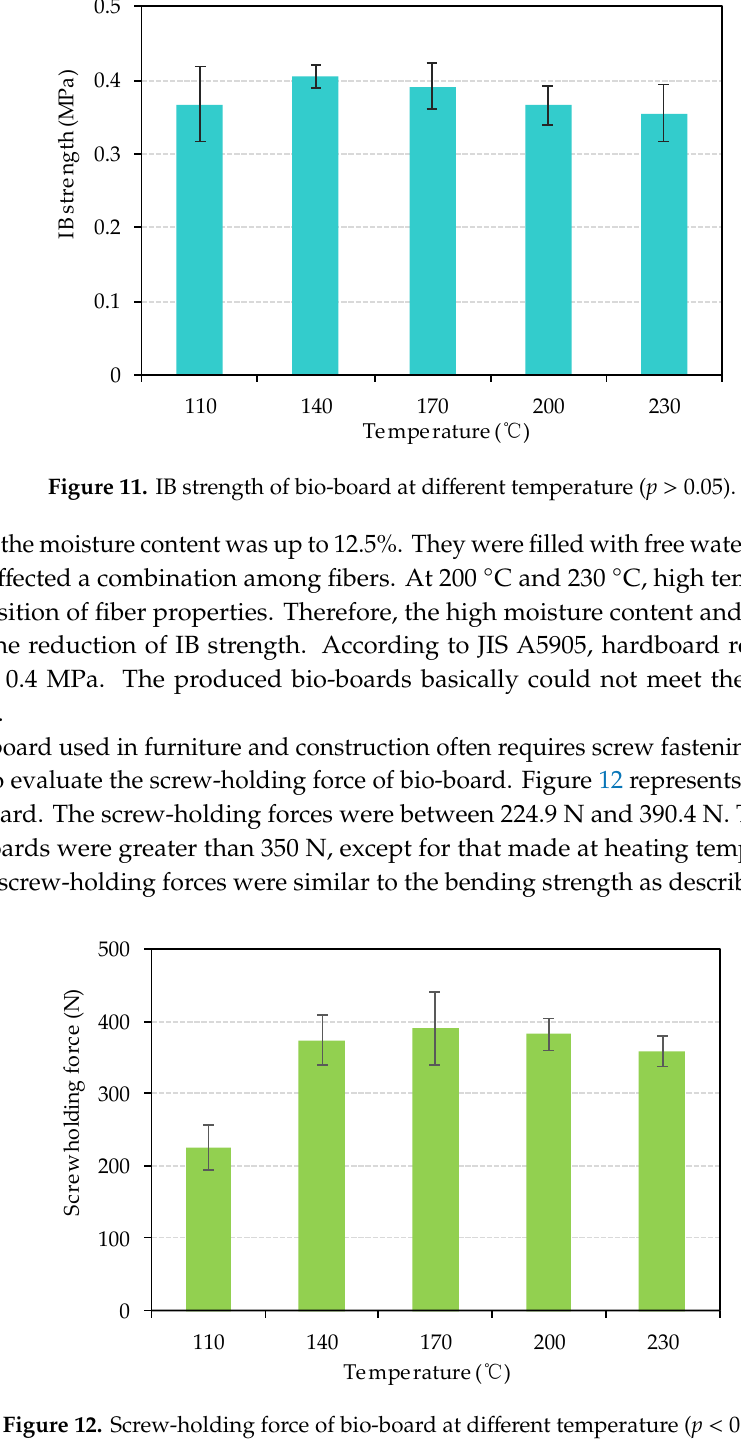
Figure 12. Screw-holding force of bio-board at different temperature (P < 0.05).